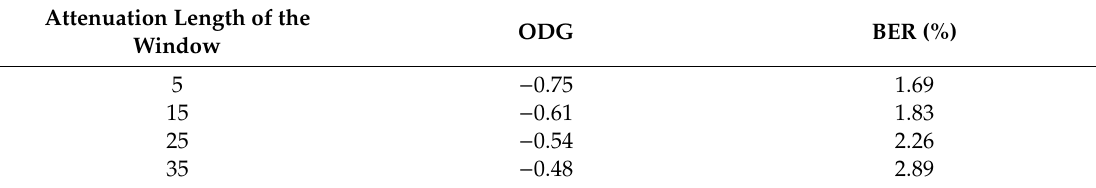
Table 5. ODG and BER values under various attenuation lengths of the window.